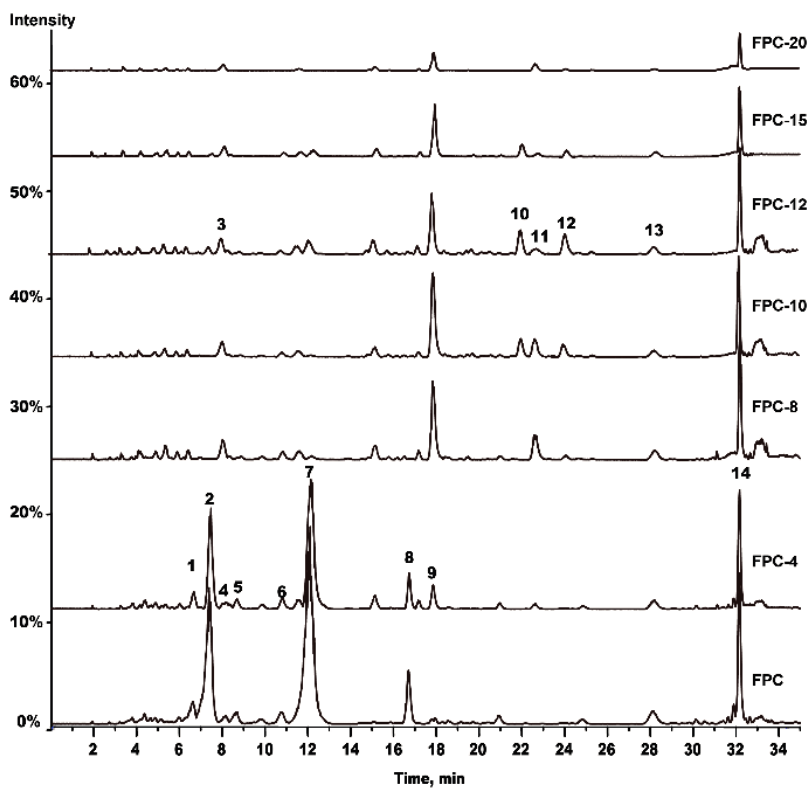
Figure 1. Representative BPC of FPC-N and its six processed products based on HPLC-MS/MS. A total of 14 peaks with large areas and good separation were regarded as “common peaks” in the